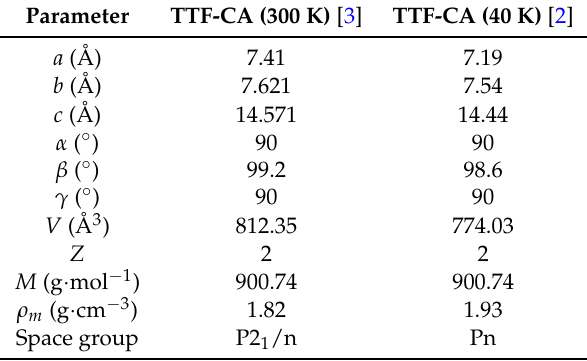
Table 1. Unit cell parameter TTF-CA for 300 K and 40 K. The data were taken from Mazerle et al. and LeCointe et al.